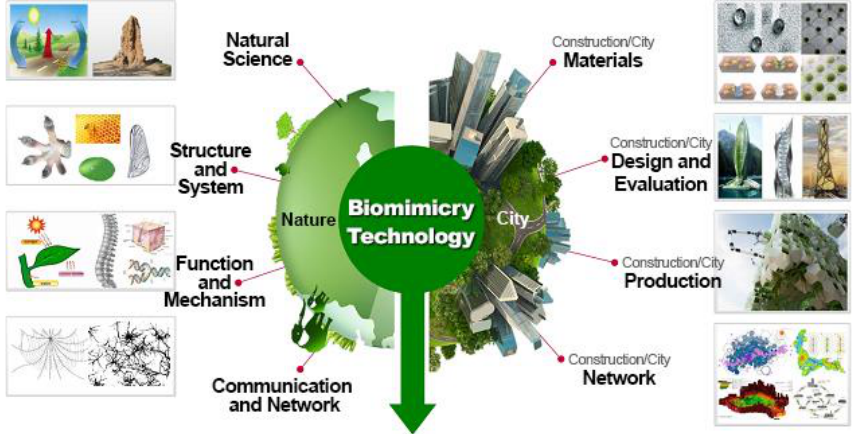
Figure 10. Similar contexts and scales of transfer from nature to architecture: at material scales, at building structure and system scale, at building function and production (performance) scales and at network and infrastructure scales.